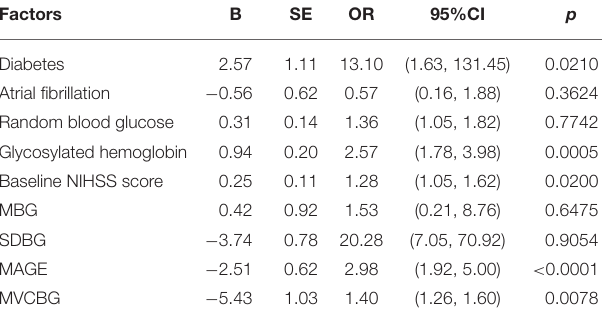
TABLE 4 | Multivariable analysis for early symptom